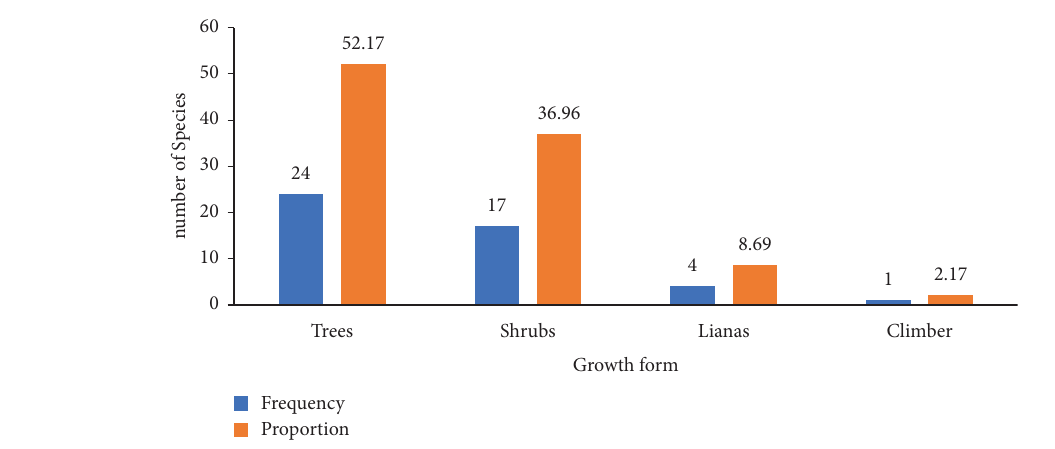
Figure 4: Plant growth forms of the study area.